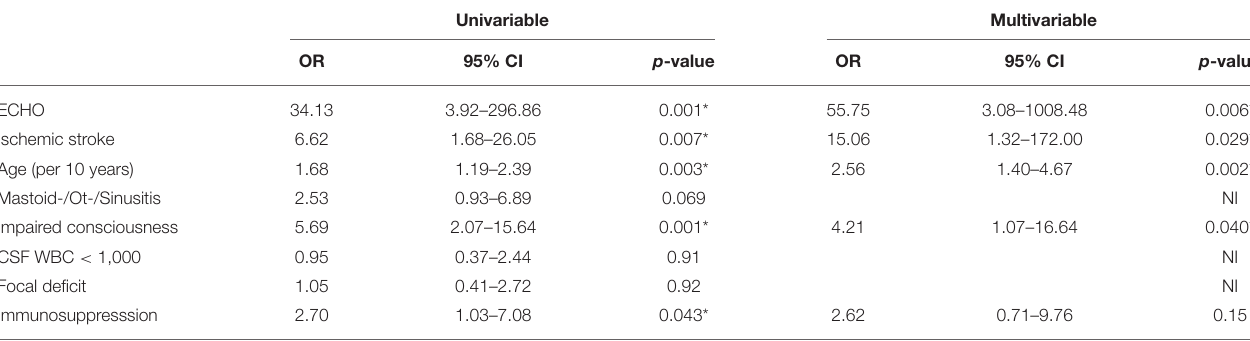
TABLE 2 | Logistic regression analysis of predictors for poor clinical outcome (mRS 5–6).